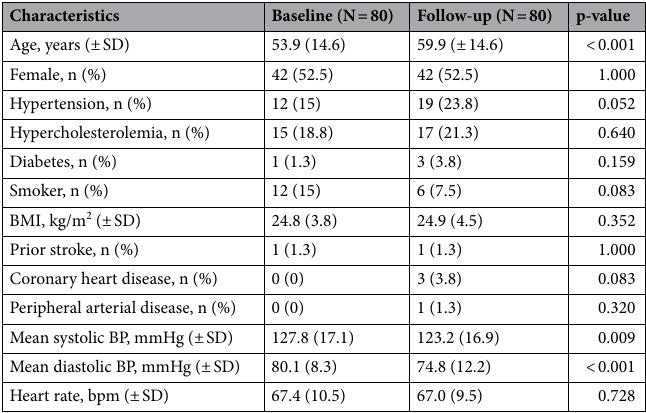
Characteristics